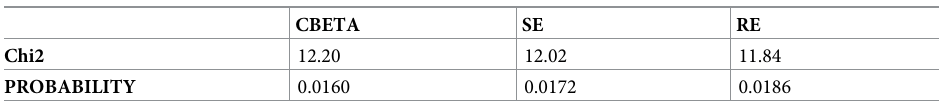
Table 3. Hausman test